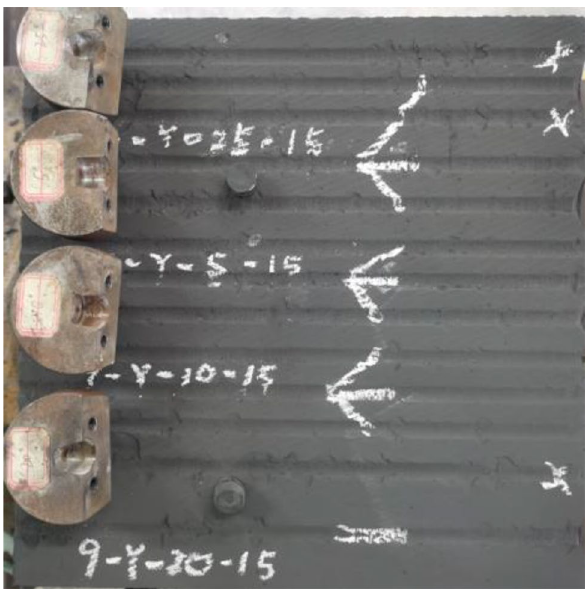
Fig. 11 Shale sample after the scraping experiment